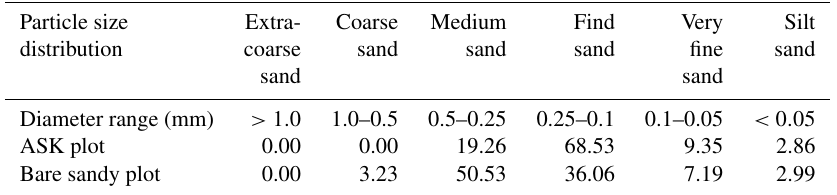
Table 2. The distribution of soil particle size at the research site. Particle size Extra- Coarse Medium Find Very Silt distribution coarse sand sand sand fine sand sand sand Diameter range